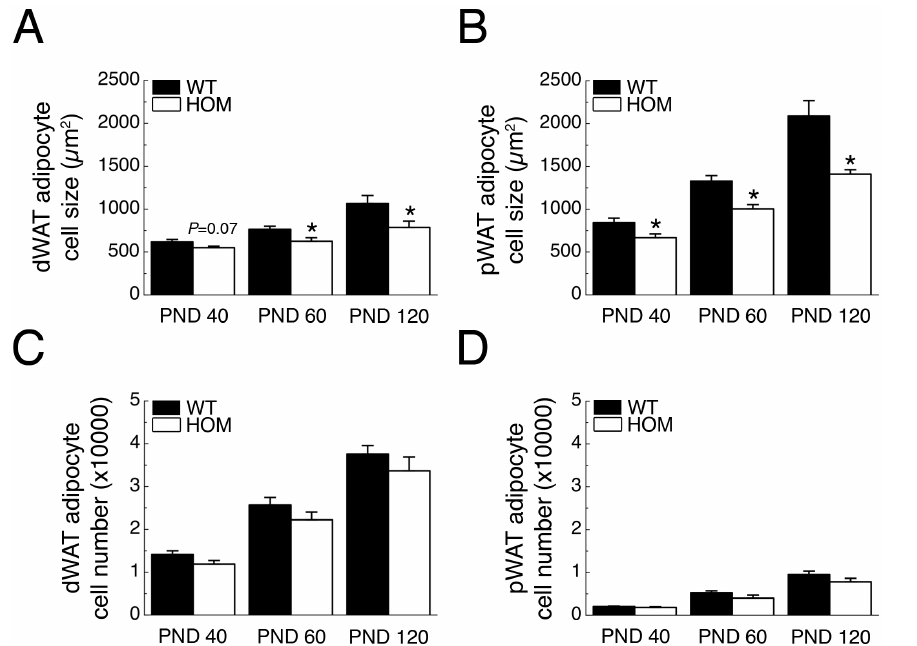
Figure 2. Pmch -deficiency decreases white adipocyte size. ( A ) dWAT- ( B ) and pWAT adipocyte cell size, ( C ) dWAT- and ( D ) pWAT adipocyte cell number of WT and HOM rats (n=8–15/group) at PND 40, 60, and 120. * P , 0.05 vs WT.